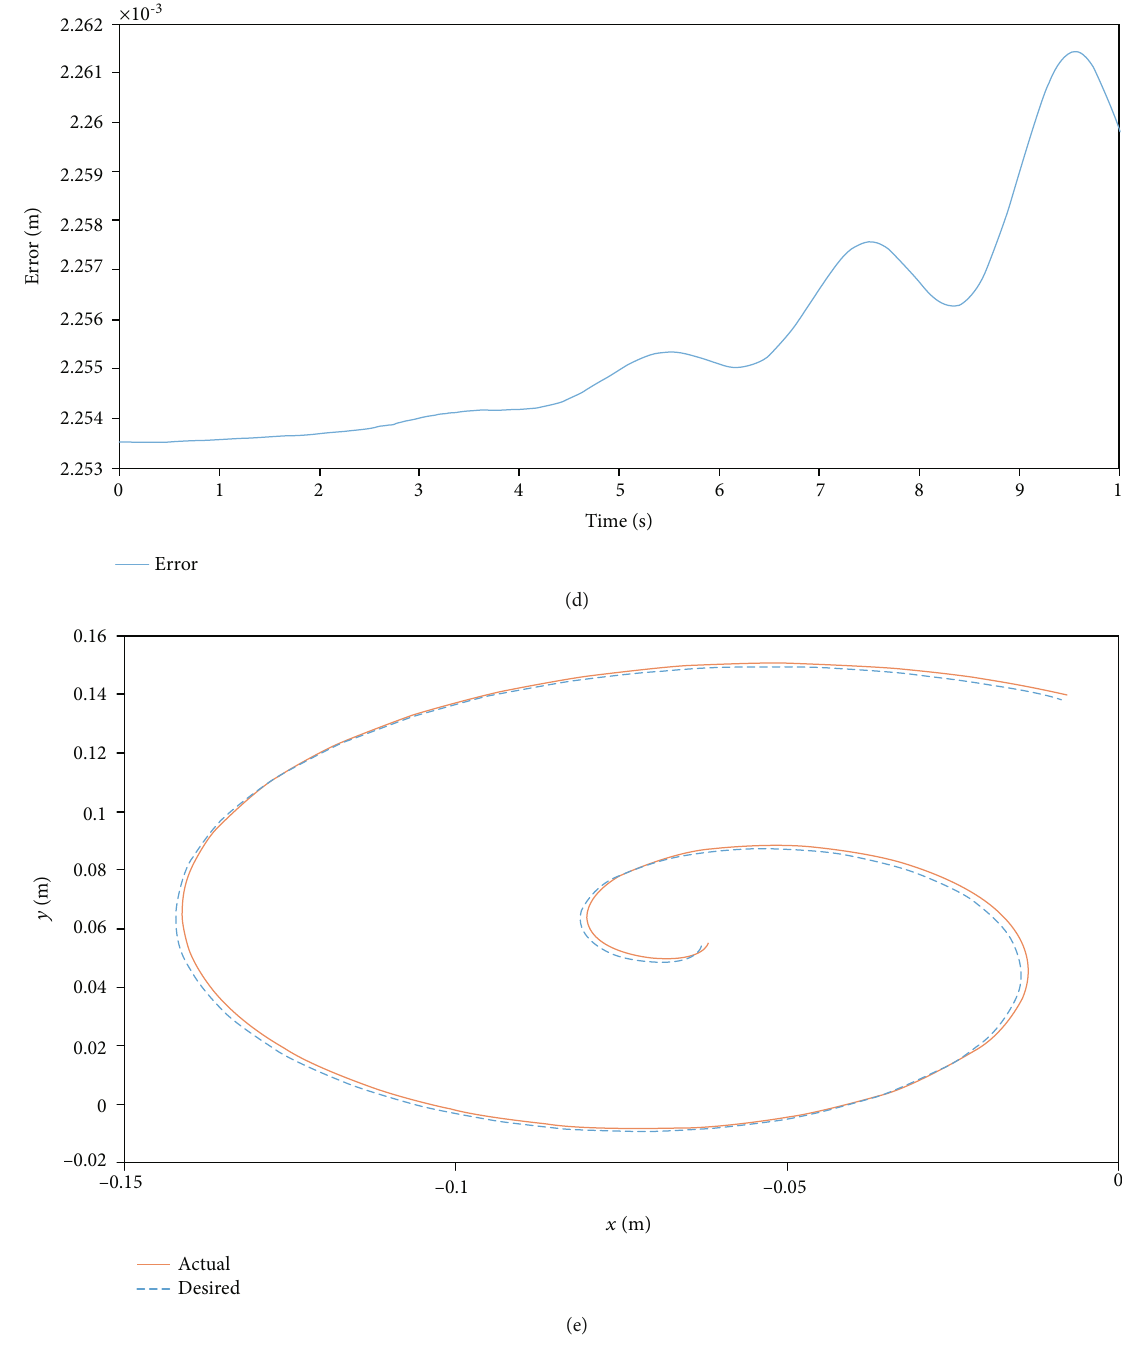
Figure 11: The result of